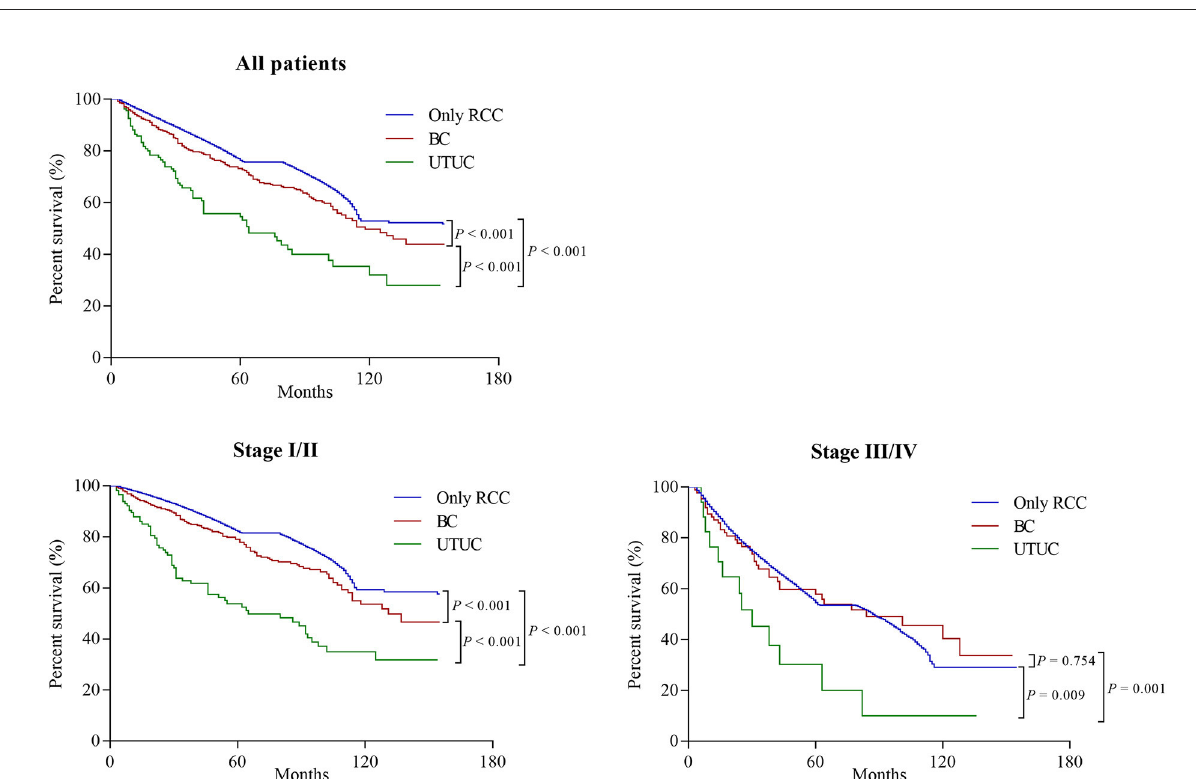
FIGURE2 Overall survival of patients who initially presented with solitary renal cell carcinoma (RCC) or synchronous RCC and urothelial carcinomas (UC) based on the location of UC (Bladder cancer [BC] and upper tract urothelial carcinoma [UTUC]), stratified by tumor stage at